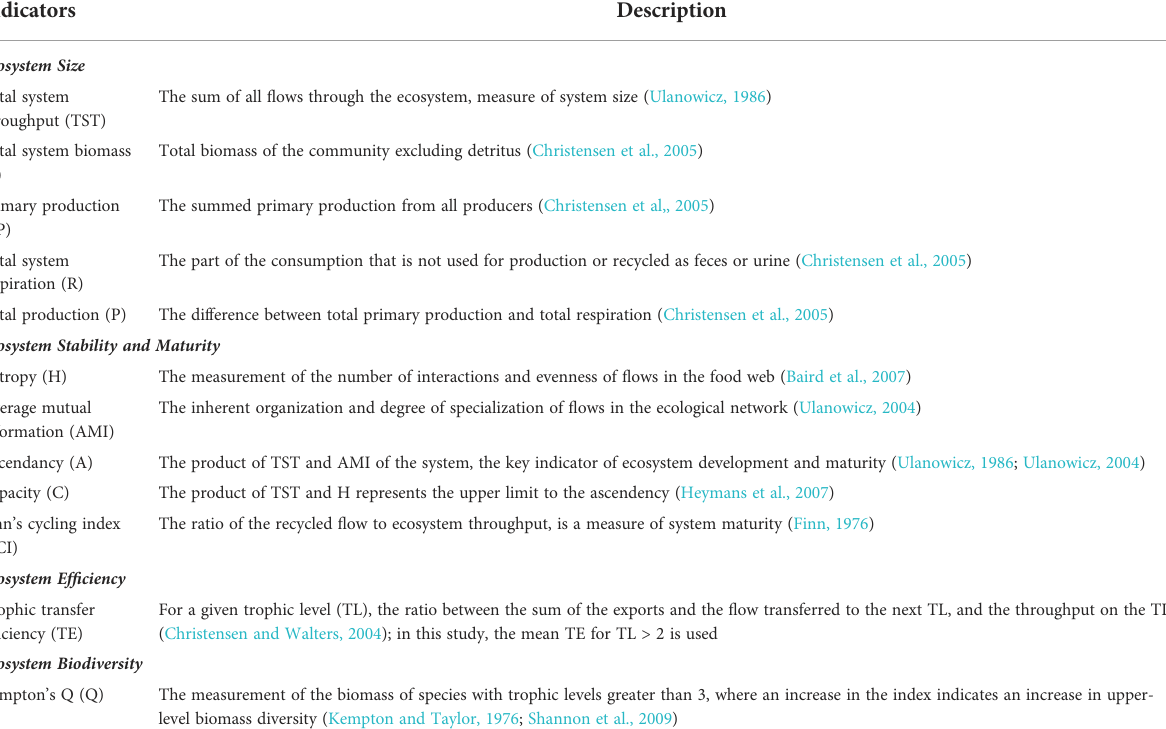
TABLE 3 Description of ecological network analysis indicators used in Laizhou Bay marine ranching ecosystem